Question: Summarize what this figure shows in one sentence.
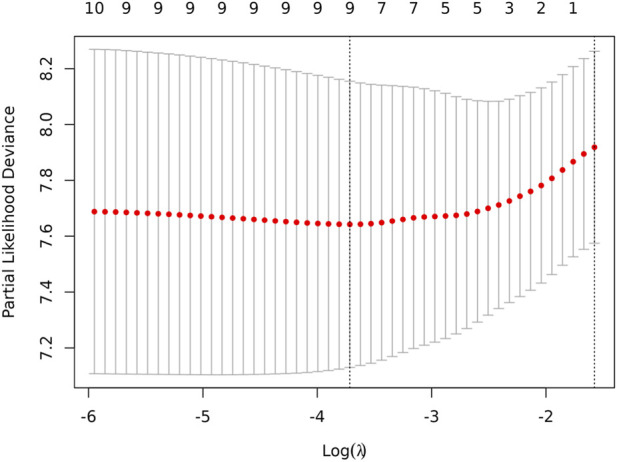
Answer: Tuning parameter (λ) selection cross-validation error curve (λ = 0.0243341096455763).